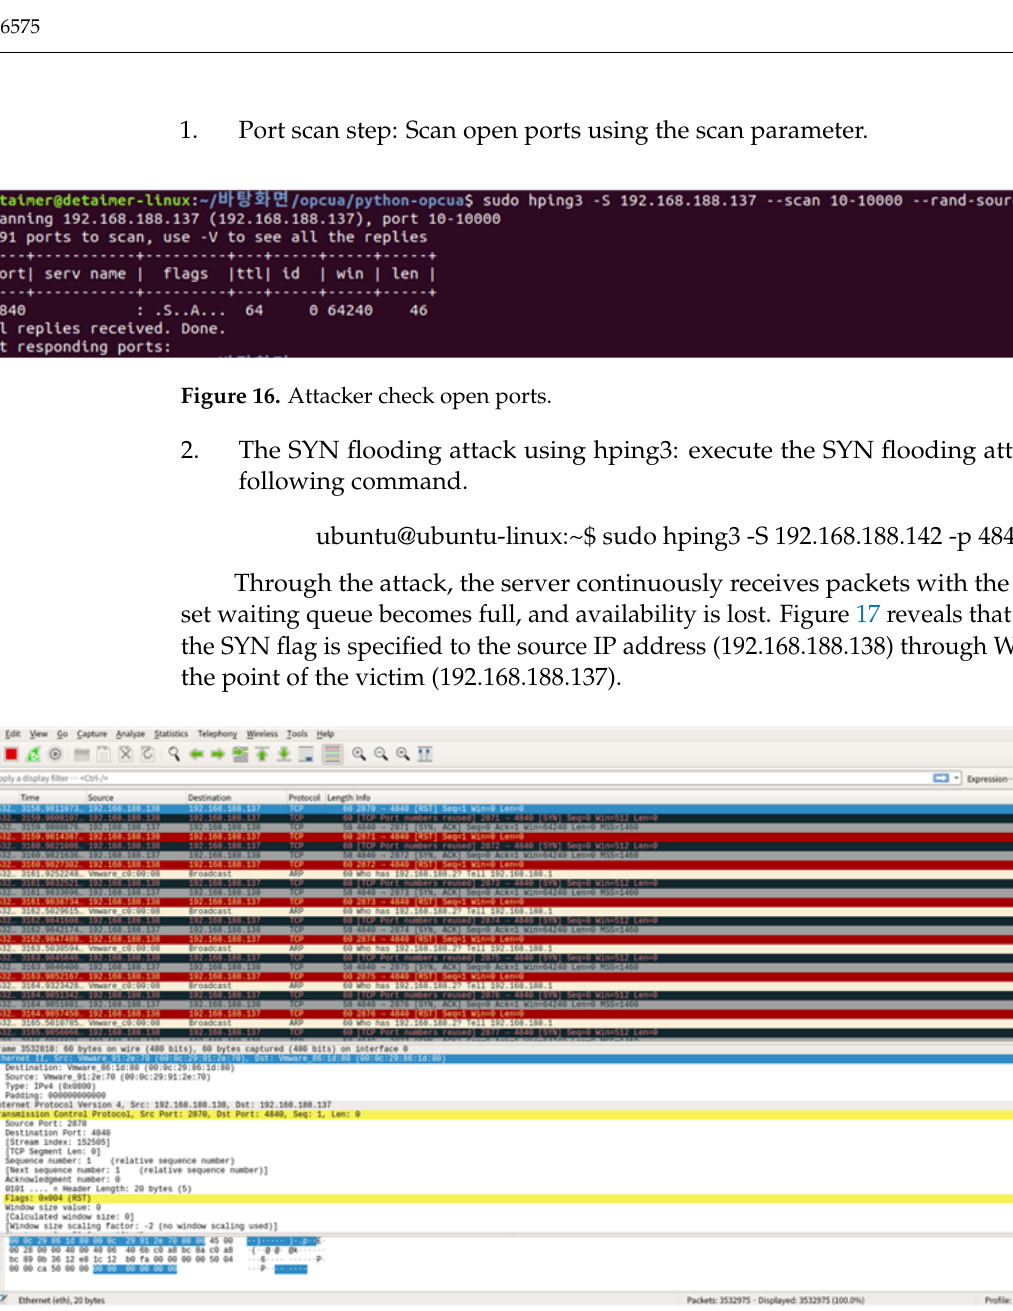
Figure 15. Screen manipulated by a rogue client.